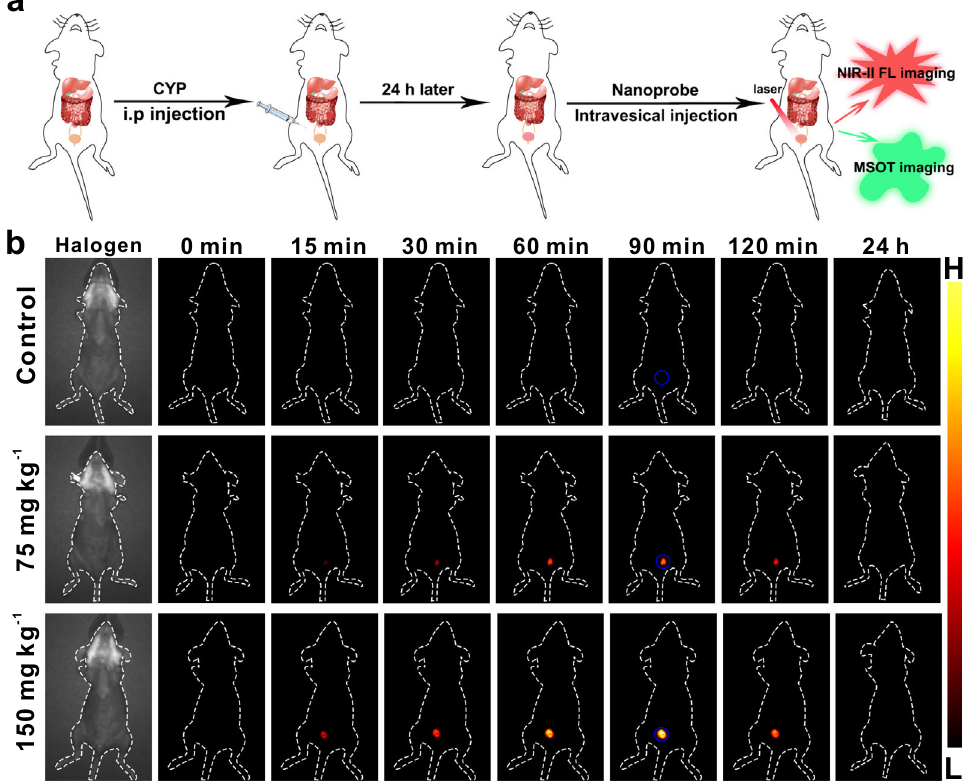
Fig. 3 Application of nanoprobe BTPE-NO 2 @F127 in interstitial cystitis mouse model via NIR-II fl uorescence imaging. a Schematic illustration for establishment of the interstitial cystitis mouse model and imaging experiment. b Representative NIR-II fl uorescence images of the control (healthy mice intraperitoneally injected with saline) and the interstitial cystitis model groups (intraperitoneally injected with 75 mg kg − 1 CYP or 150 mg kg − 1 CYP for 24 h) at various time points post-injection of BTPE-NO 2 @F127. Color bar: L: 6.0 × 10 2 , H: 6.0 × 10 4 (arb. units). The mice were in supine position. Blue circle: bladder region. CYP cyclophosphamide, FL fl uorescence, MSOT multispectral optoacoustic